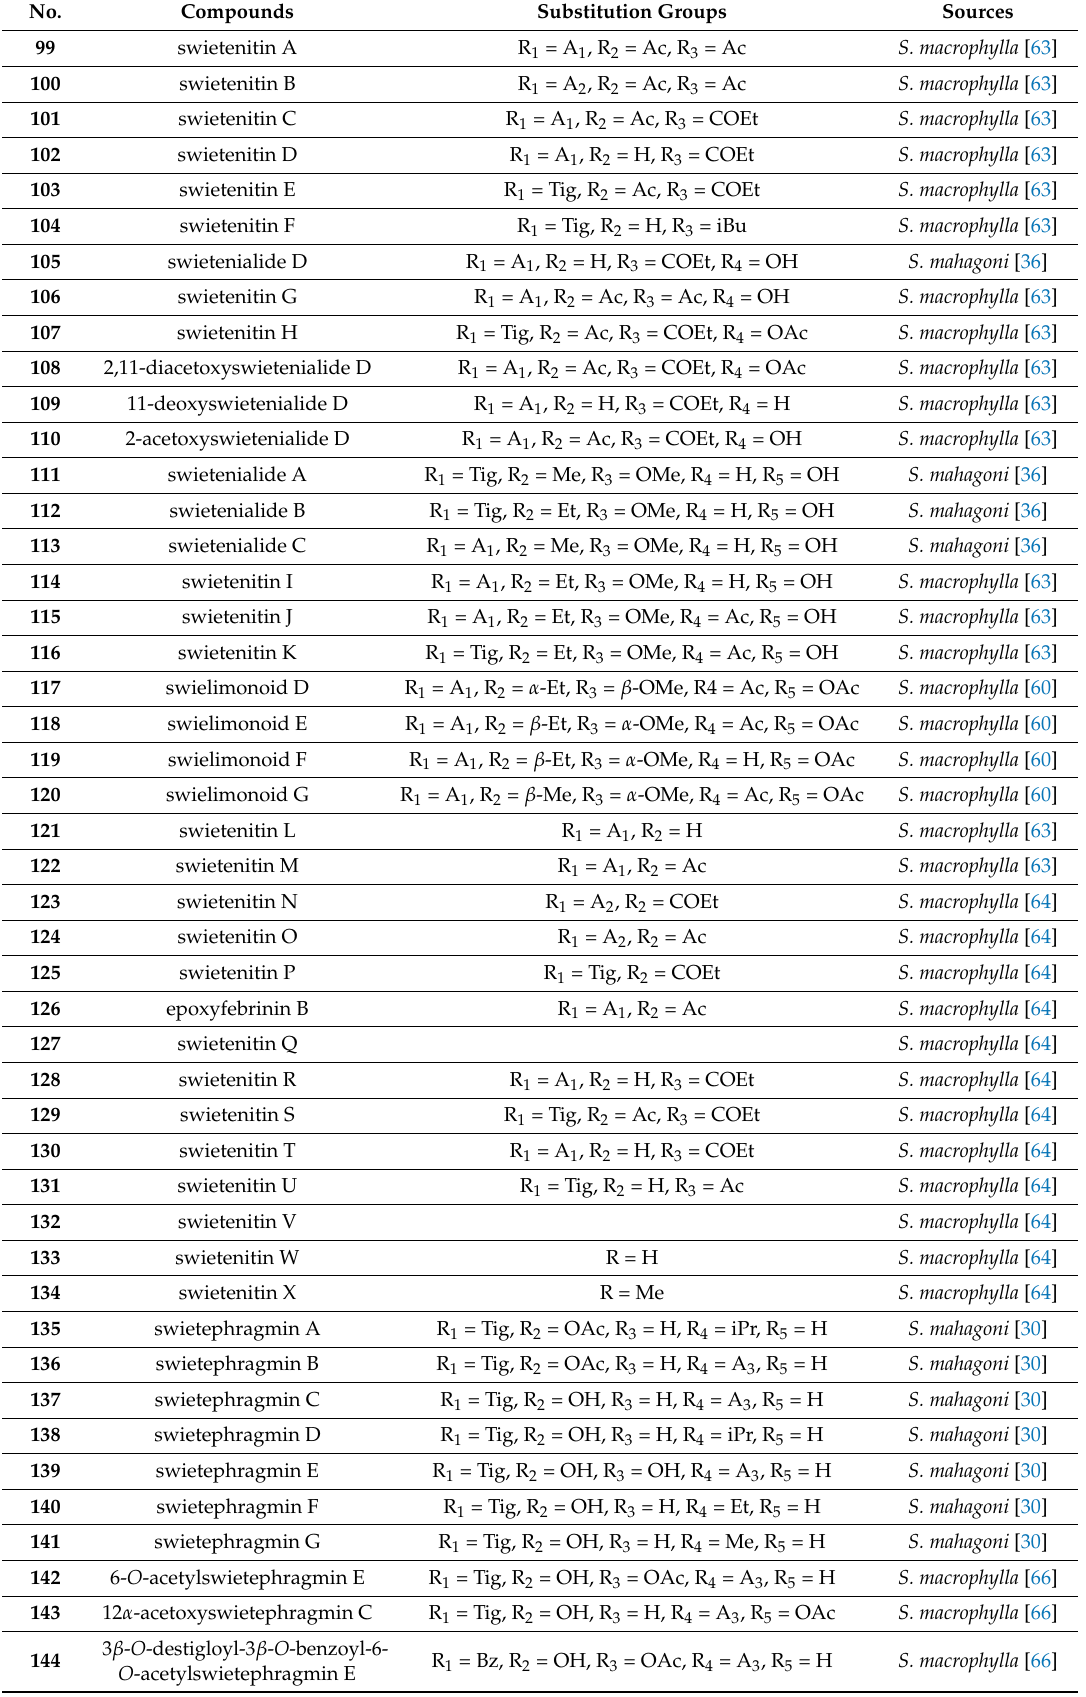
Table 4. Structures and sources of phragmalin-type limonoids 99 – 153